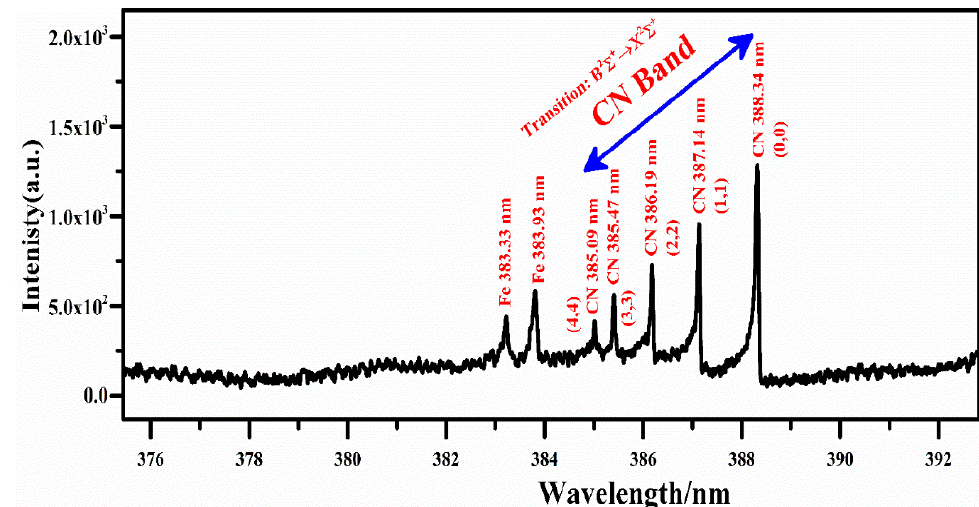
Figure 3. CN molecular emission spectrum due to the vibrational transitions; (0-0), (1-1), (2-2), (3-3) and (4-4), with a wavelength range from 375 nm to 393